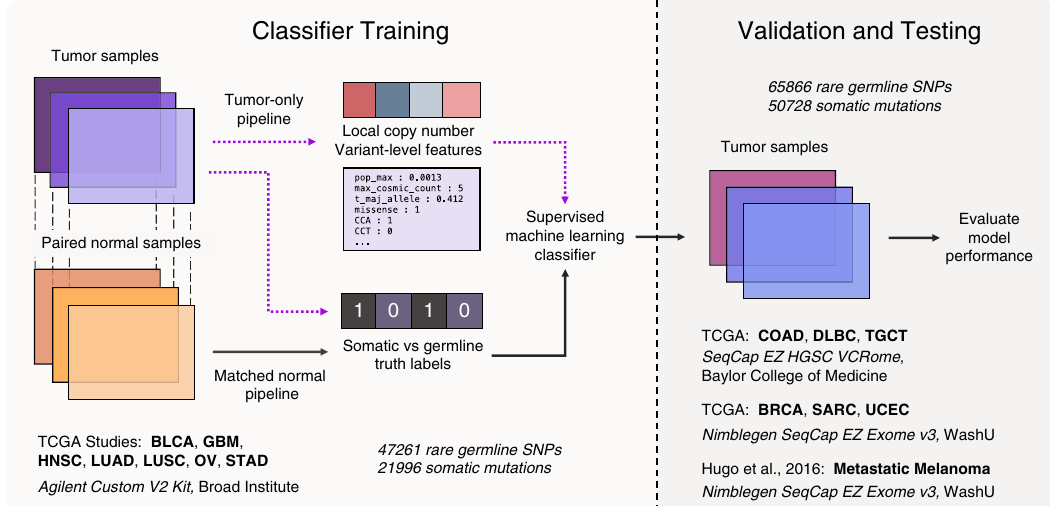
Fig. 1 Machine-learning classi fi er for tumor-only somatic variant retrieval. To improve the reliability of tumor-only variant calling in whole- exome sequencing (WES) samples, we classify mutations as “ somatic ” or “ germline ” using TabNet, an attentive deep-learning classi fi er for tabular data, and gradient boosting tree-based methods XGBoost and LightGBM. We train models on solid tumor data in a supervised manner, using features from a tumor-only analysis and truth labels derived from a matched-normal analysis. We evaluate the trained model blindly on holdout tumor sample data that are biologically and technically distinct from the training set data — i.e., from different tissues of origin, exome- capture kits, and sequencing centers. Classi fi er training (left): To prepare the training set, we fi rst align WES data for tumor and matched-normal samples from 105 oncology patients in The Cancer Genome Atlas across seven studies (BLCA bladder urothelial carcinoma, GBM glioblastoma multiforme, HNSC head and neck squamous cell carcinoma, LUAD lung adenocarcinoma, LUSC lung squamous cell carcinoma, OVovarian serous cystadenocarcinoma, STAD stomach adenocarcinoma). For all patients, variant calling is performed with and without the matched- normal reference. CNV analysis is performed without the matched-normal samples. We extract features from the tumor-only variants and CNV data. The somatic or germline status of each variant detected in the matched-normal variant calling pipeline is used as the ground truth label — 0 for germline and 1 for somatic. We combine the features and truth labels to train TabNet, XGBoost, and LightGBM classi fi ers to distinguish somatic from germline variants. Validation and testing (right): The model with the best average precision score on a validation set (COAD, DLBC, and TGCT, SeqCap EZ HGSC VCRome, Baylor College of Medicine) is selected and applied to two holdout test datasets of tumor-only samples: TCGA BRCA, SARC, and UCEC, and the metastatic melanoma dataset of ref. 39 , using the Nimblegen SeqCap EZ Exome v3 kit. The accuracy of the tumor-only classi fi cation method is benchmarked using truth labels from the associated matched-normal